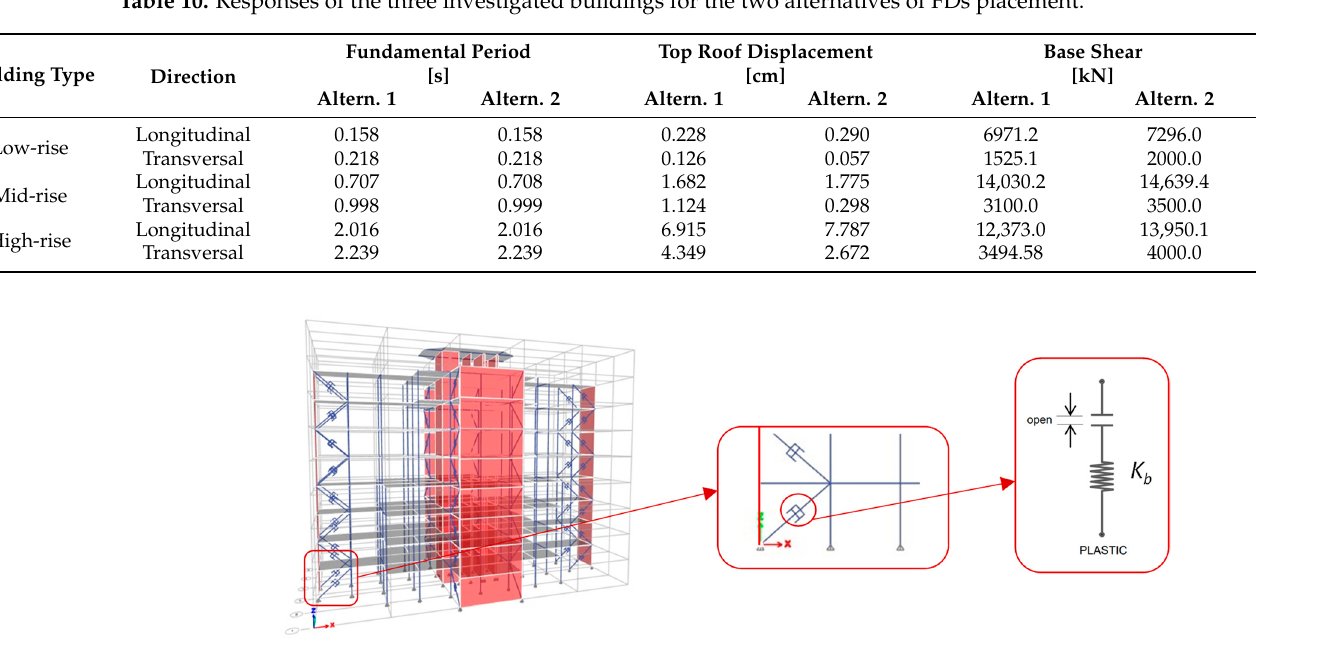
Table 10. Responses of the three investigated buildings for the two alternatives of FDs placement.